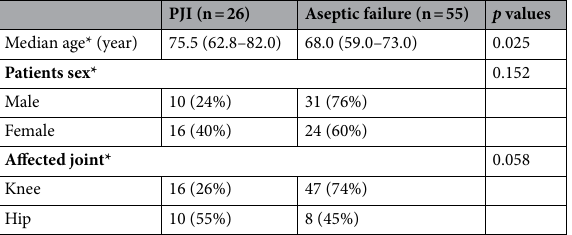
Table 1. Baseline demographics of the enrolled patients. *The median values are given as the number of cases and the percentage or IQR in parentheses.